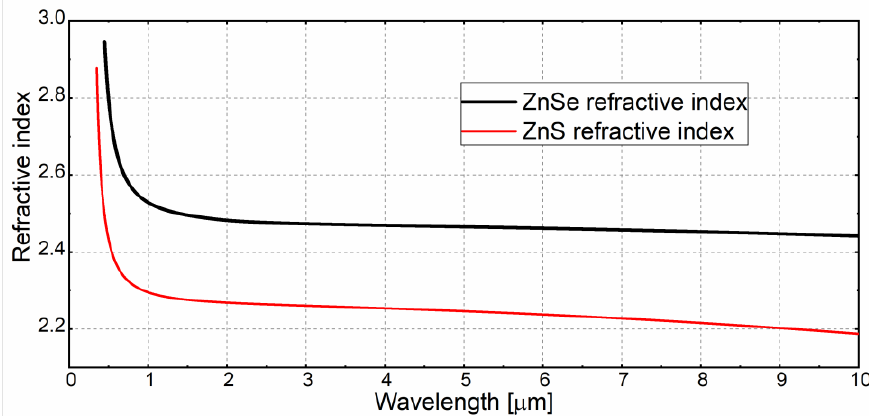
Figure 6. Refractive index of ZnSe (black) single layer and ZnS (red) single layer taken from [19].